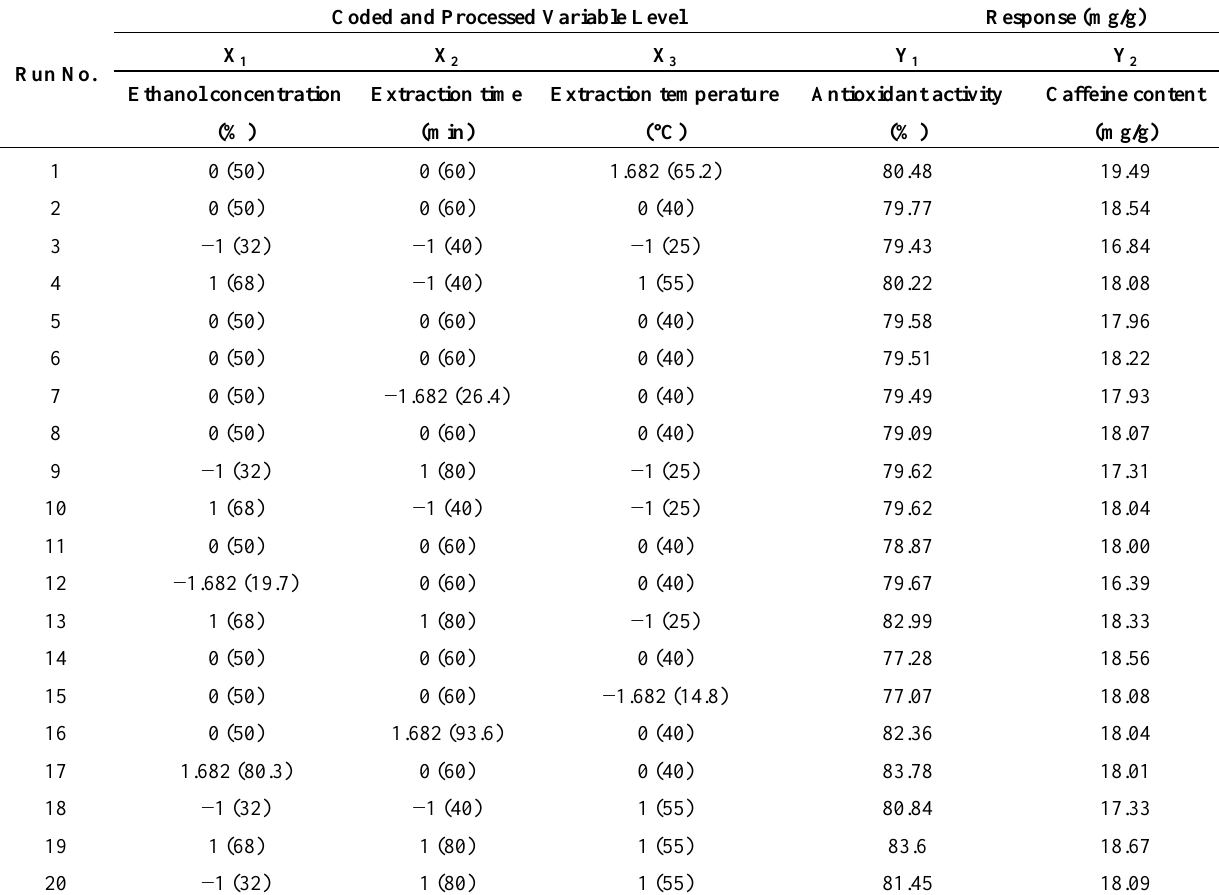
Table 1. Coded and processed variables levels used in experimental design for RSM.